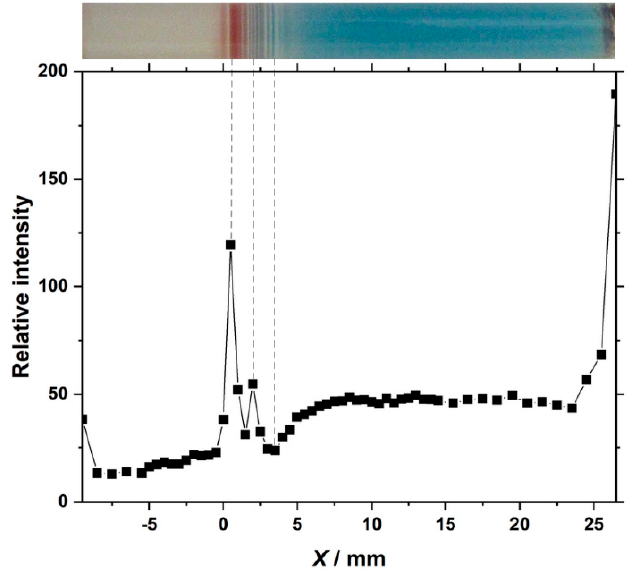
Figure 11. Fe K α intensity distribution of the multicolored pattern formed under the cyclic alternat- ing voltage, obtained after removing the unreacted ions. An image of the gel sample is displayed at the top to facilitate comparison with the periodic bands.